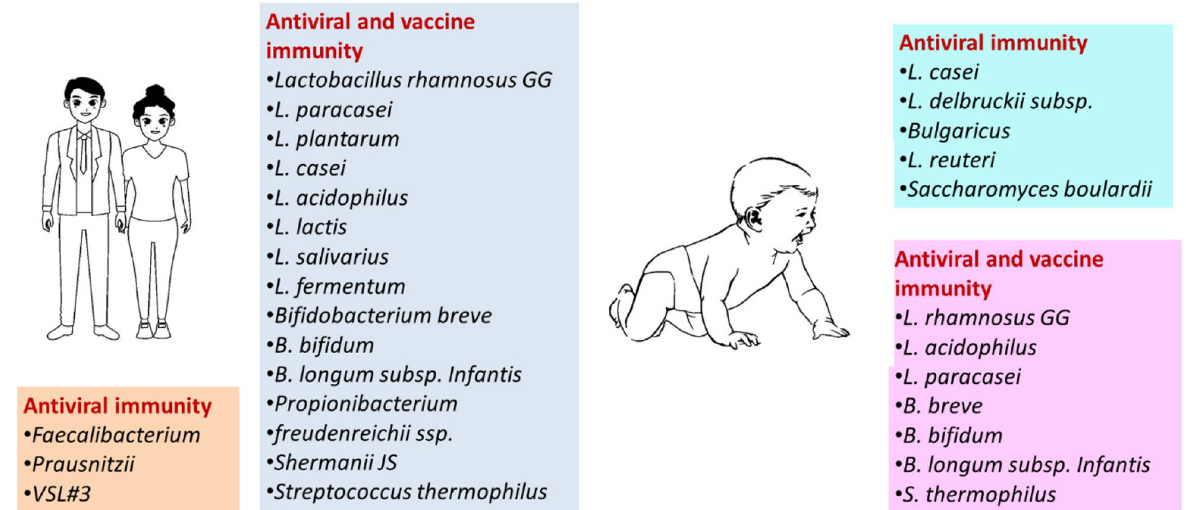
Fig. 4 Probiotic that possesses antiviral properties as demonstrated in adults and